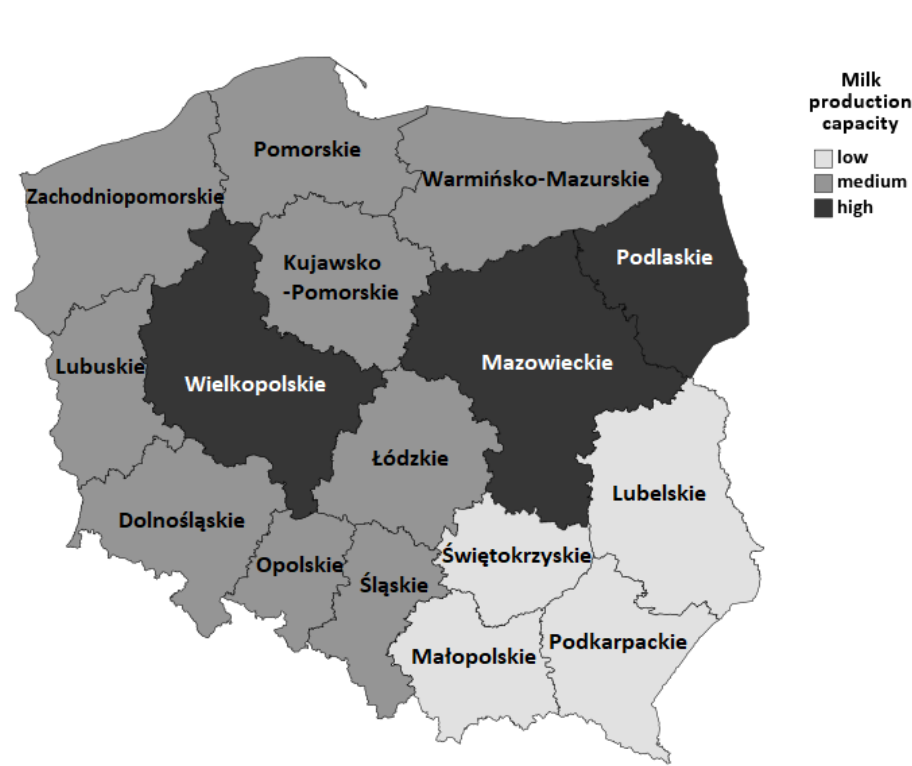
Figure 1. Milk production capacity by province (authors’ elaboration based on data from Table 12) .